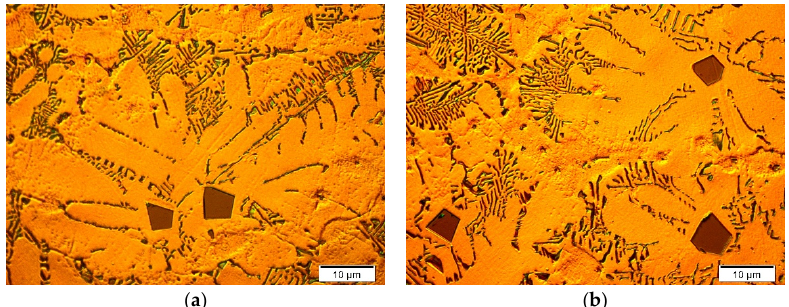
Figure 6. Micrographs of Mg/Mg 2 Si–HR composite microstructure presenting magnesium dendrites surrounding primary Mg 2 Si crystals. ( a , b ) shows two micrographs taken from different areas of Mg/Mg2Si–HR.